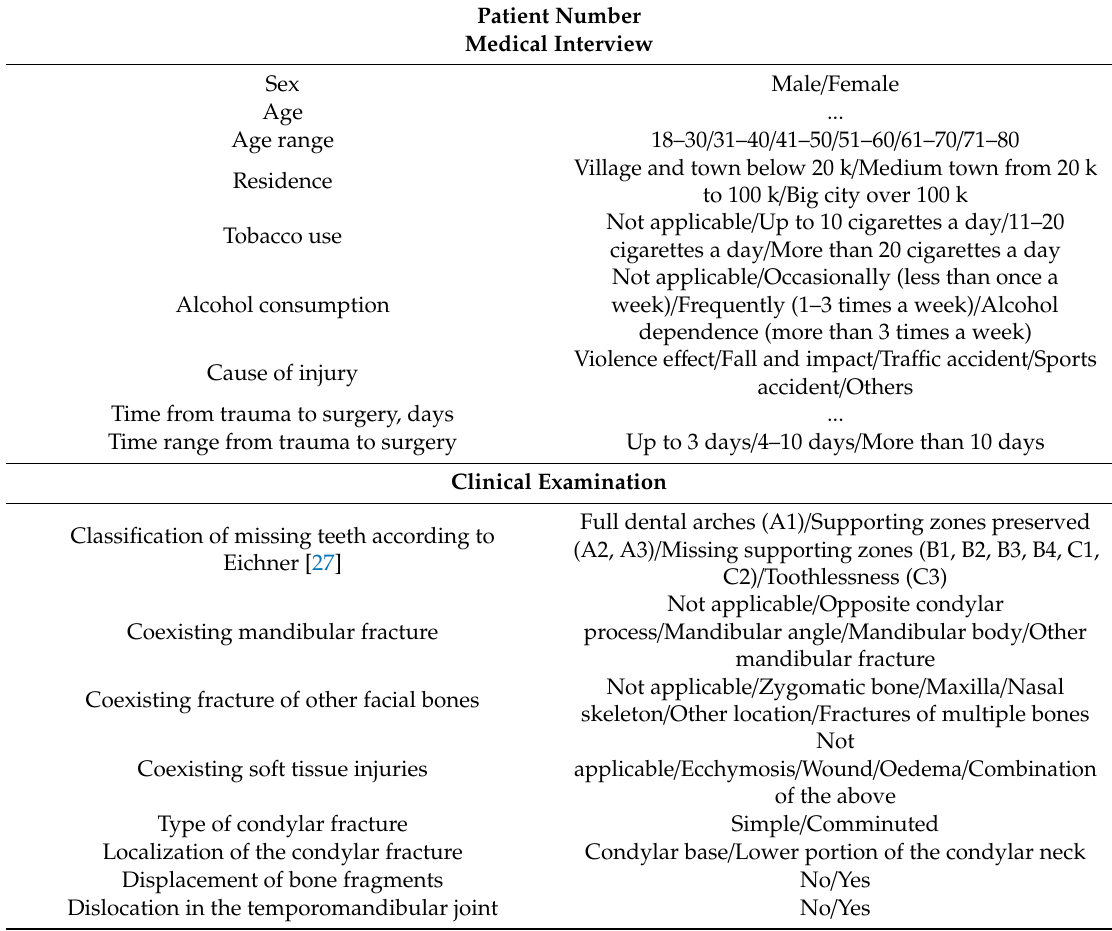
Table 3. Medical interview and examination